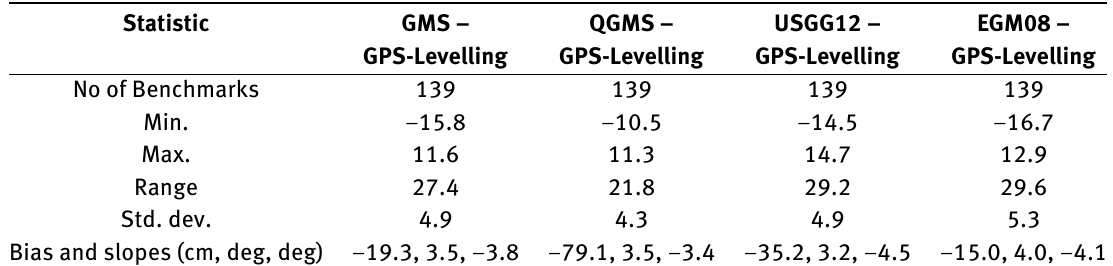
Table 7: Statistics of the differences between the different geoids and the GPS-levelling benchmarks after the removal of systematic slopes by a 3-parameter fitting for the California test area. Unit is in cm